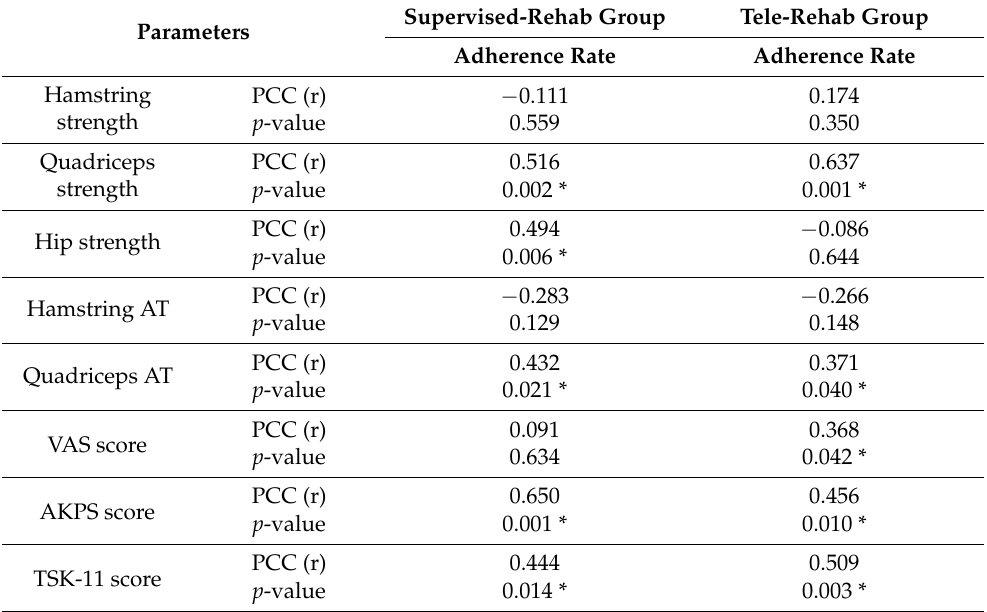
Table 4. Correlations between adherence rate and rate of change in muscle strength, muscle activation time, and patient-reported